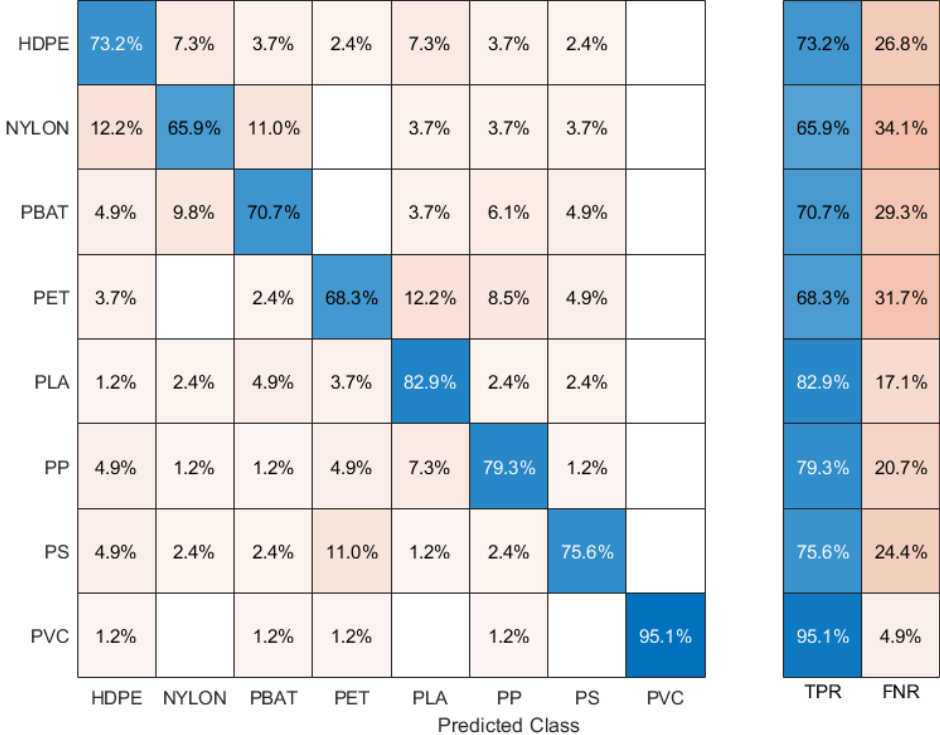
Figure 3. Confusion matrix resulting from ANN classification.